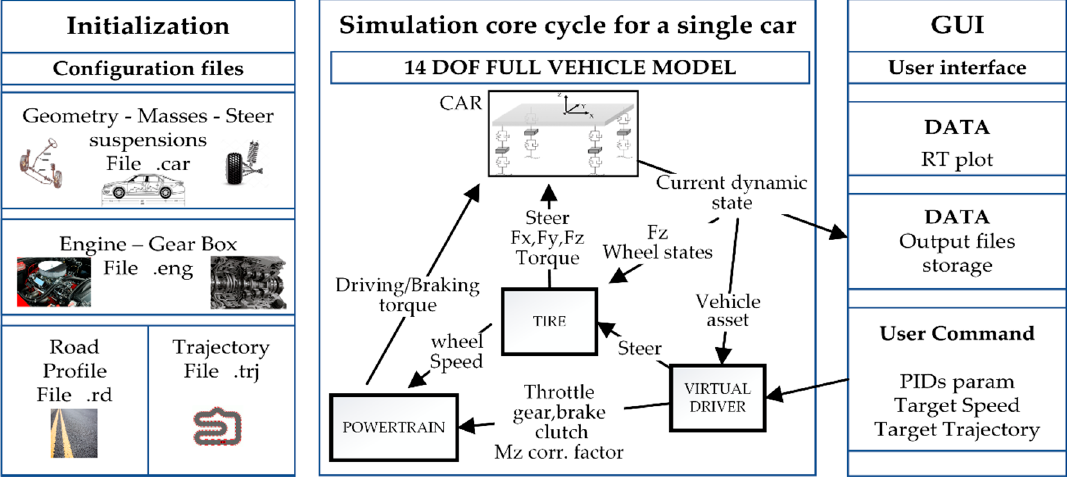
Figure 1. Diagram of the simulator architecture.